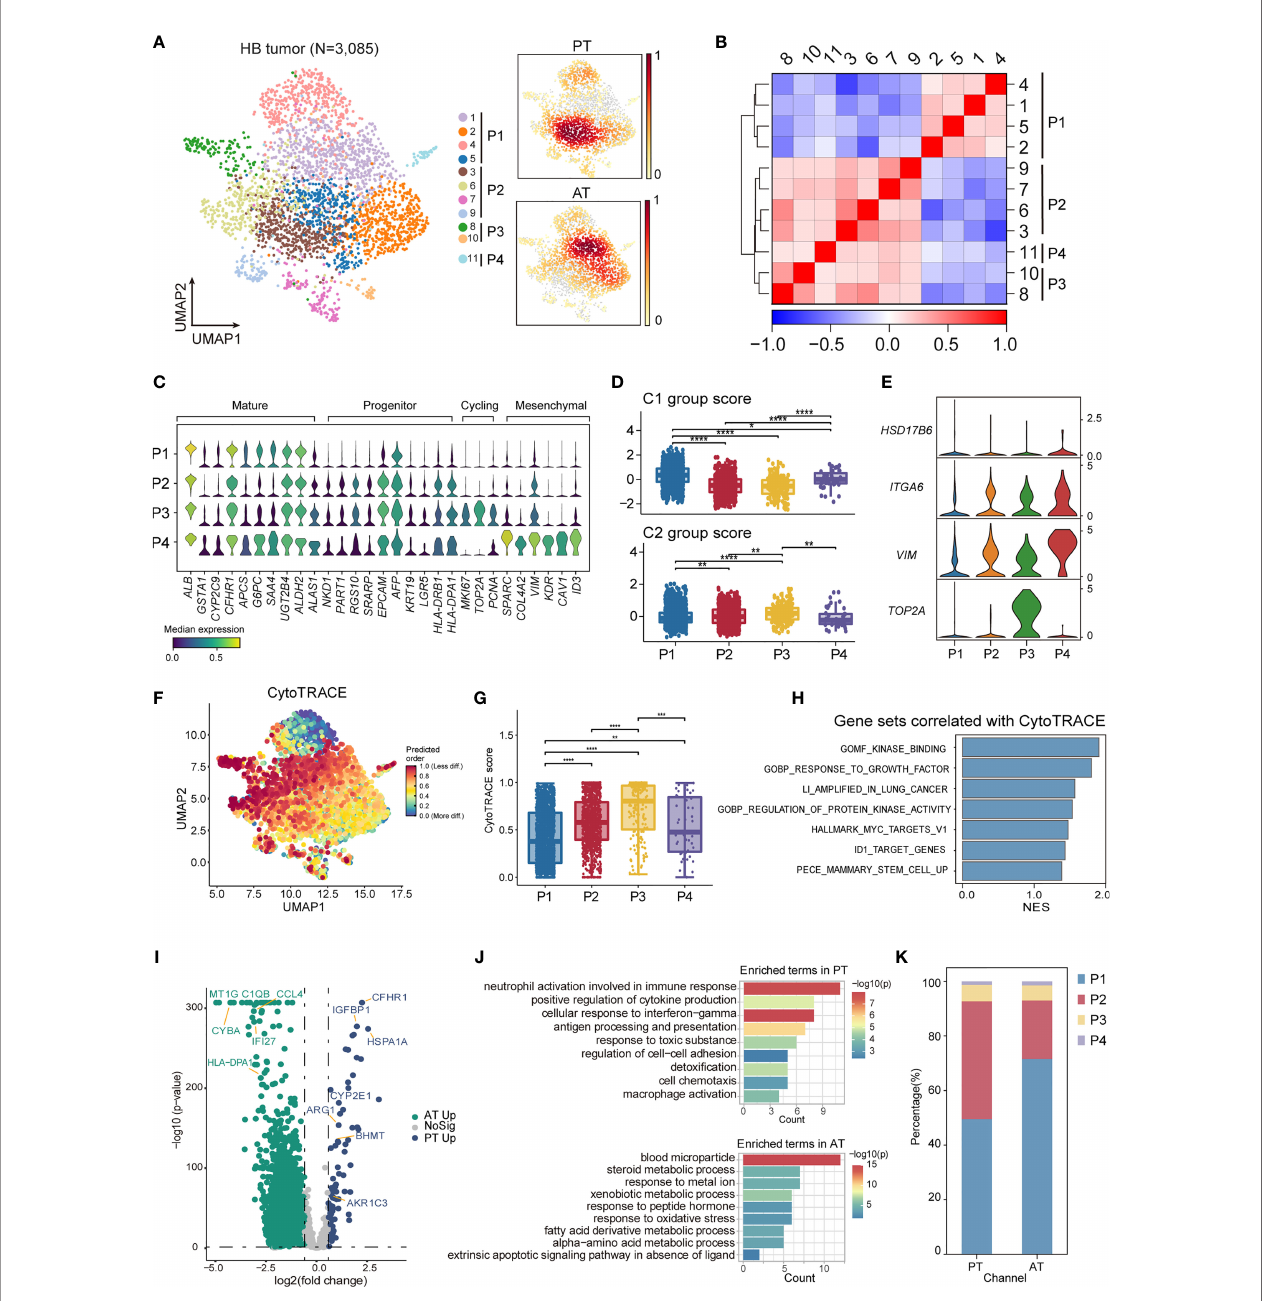
FIGURE 5 | The intratumoral heterogeneity within HB malignant cells. (A) UMAP visualization of 3,085 tumor cells from HB colored by clusters (left) and density of sample distribution(right). (B) Heatmap displaying the Pearson correlation coef fi cients calculated between average gene expressions of tumor clusters. (C) Violin plots showing the expression distribution of selected genes involved in cell cycle genes, and markers speci fi c to mature hepatocytes, hepatoblasts, and mesenchymal cells in HB tumor subtypes. (D) Boxplots showing the expression score of HB C1 and C2 group gene sets curated from Cairo et al. in HB tumor subtypes. *P < 0.05, **P < 0.01, ***P < 0.001, ****P < 0.0001, two-sided Wilcoxon test. (E) Violin plots showing the expression of four-gene signature curated from Hooks et al. in HB tumor subtypes. (F) UMAP visualization of CytoTRACE values of HB malignant cells. (G) Boxplots showing CytoTRACE values in HB tumor subtypes. *P < 0.05, **P < 0.01, ***P < 0.001, ****P < 0.0001, two-sided Wilcoxon test. (H) GSEA analysis of genes correlated with high CytoTRACE values (associated with immaturity). (I) Volcano plot showing differentially expressed genes between HB PT (green dots) and RT tumor cells (blue dots). The names of selected important genes are indicated in the plots. (J) Bar chart showing the enrichment of GO terms, based on top50 upregulated genes in PT or AT malignant cells. (K) Bar plot indicating the percentage of tumor subtypes in HB PT and AT samples. HB, hepatoblastoma; PT, primary tumor; AT, tumor after